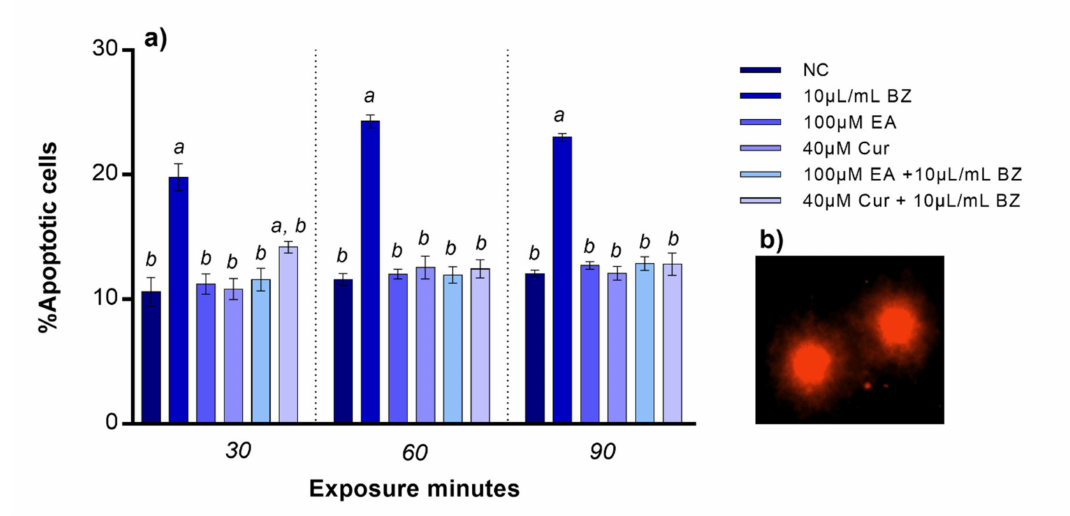
Figure 3. ( a ) Percentage of apoptotic zebrafish blood cells (y-axis) at different exposure timepoints (x-axis). Benzene—BZ; Ellagic acid—EA; curcumin—Cur; negative controls—NC. Letters correspond to diverse statistical significances (ANOVA); a : p < 0.05 in comparison with NC; b : p < 0.05 in comparison with BZ exposure. ( b ) Apoptotic zebrafish blood cells analyzed with Nikon Eclipse E-600